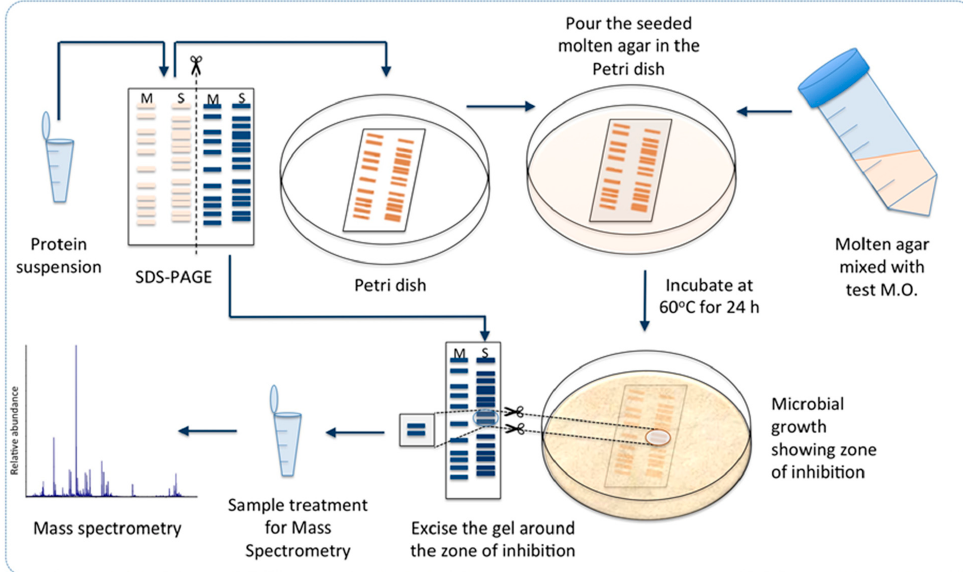
Scheme 1. Workflow for identification of potential antimicrobial protein candidates in Geobacillus sp. ZGt-1: Desalted protein extract from Geobacillus sp. ZGt-1 was fractionated by SDS-PAGE, followed by detection of antibacterial activity on the gel against test microorganism (M.O.) and analysis of the active zone by mass spectrometry. S: sample, M: protein marker in the SDS-PAGE cartoons in the scheme. The experimental details are provided in the text.